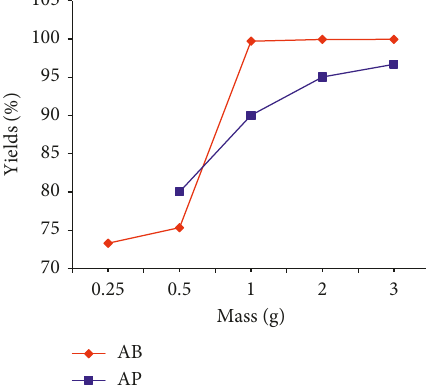
Figure 7: Variation of the adsorption yield according to the initial concentration of methyl green (MG).